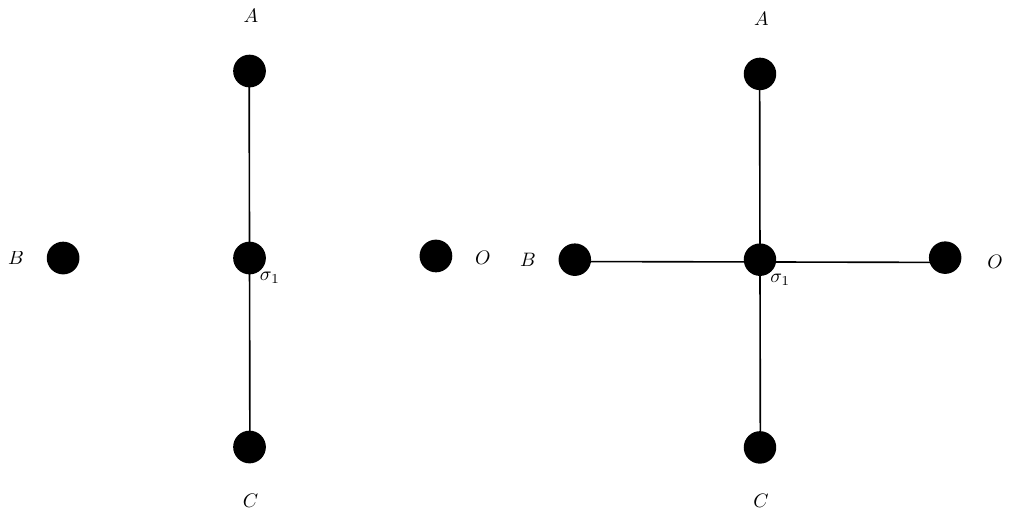
Figure 6 . Star graphs for N = 3 whose entropy vectors calculated using min cuts correspond to PT AC and PT ABCO . The coefficients relating the S and K basis are determined by the entangle- ment entropy of the corresponding star graph. For example S S AB ( PT AC ) = 1 and S AB ( PT ABCO ) = 2